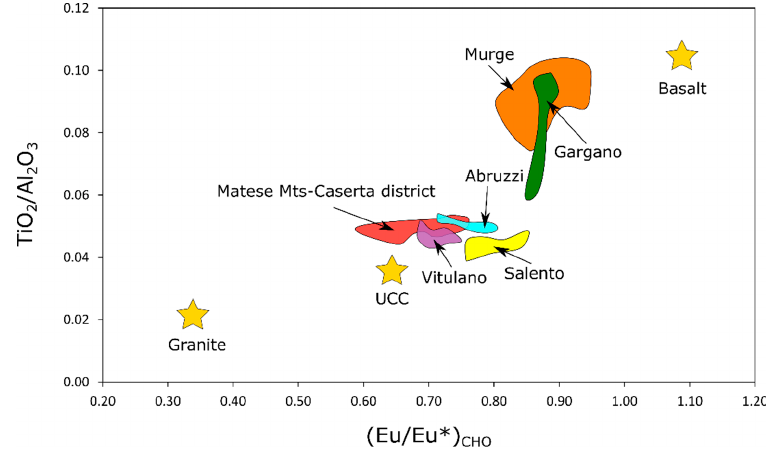
Figure 11. Eu/Eu* vs. TiO 2 /Al 2 O 3 binary diagram showing field composition of Italian bauxites Figure 11. Eu/Eu*vs. TiO 2 /Al 2 O 3 binarydiagramshowingfieldcompositionofItalianbauxites[5,7,11,22,24–26]. [5,7,11,22,24–26]. UCC (upper continental crust [47]). UCC (upper continental crust